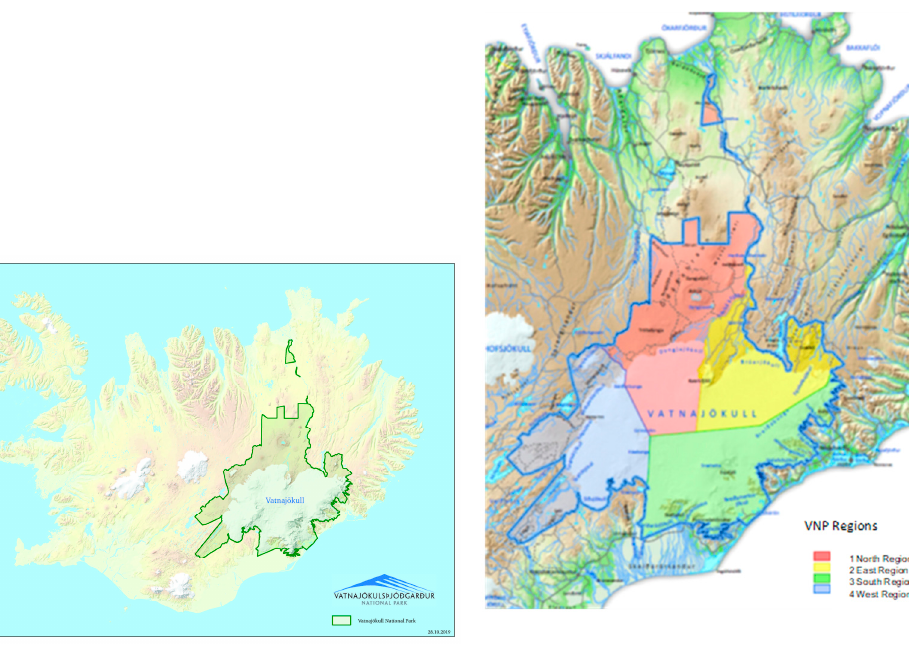
Figure 2. Maps of Vatnajökull National Park in Iceland and its four administrative regions (Source: Vatnajökull NP).